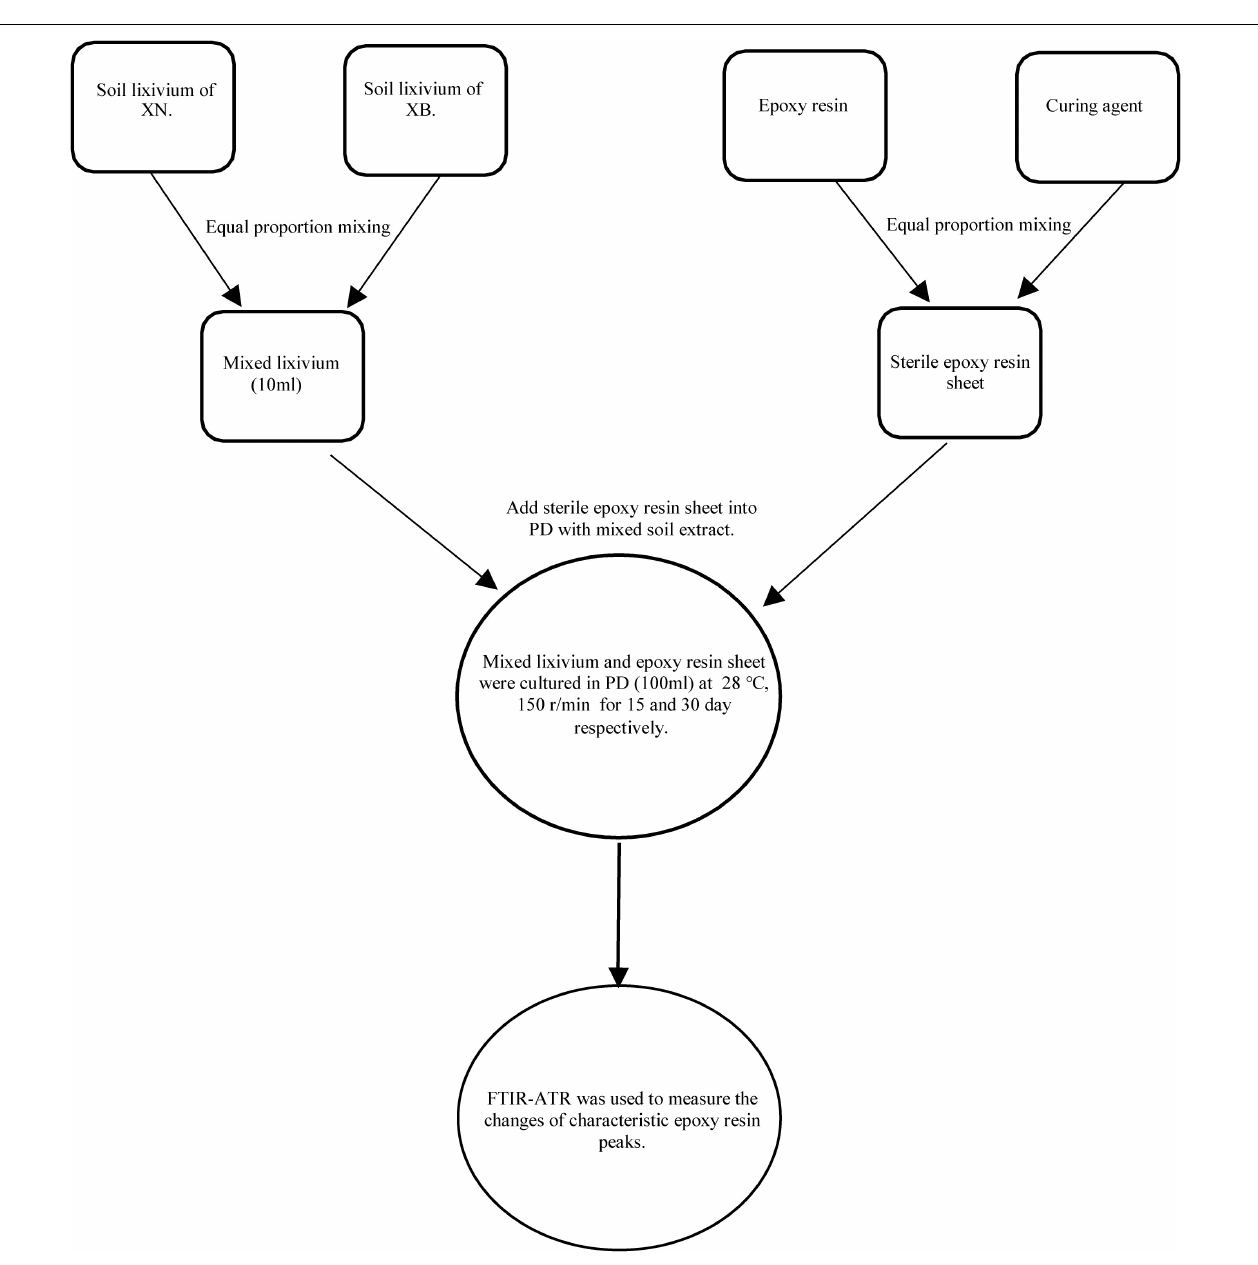
FIGURE 2 | Flow chart of protective materials degradation